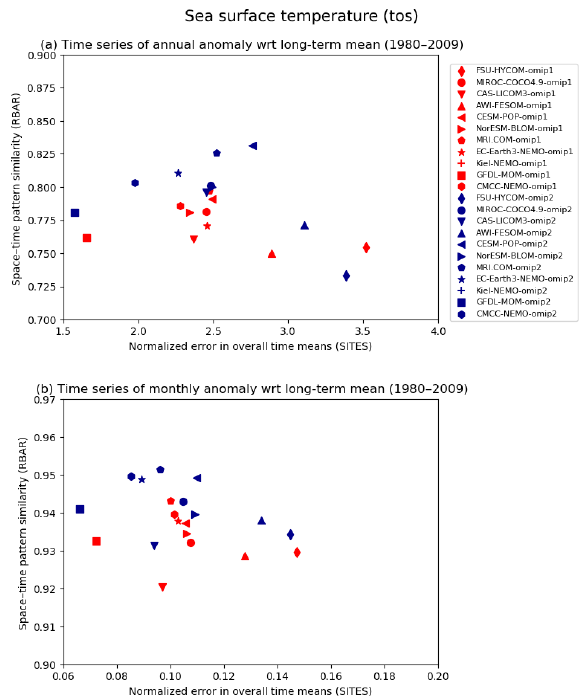
Figure E6. A model performance diagram showing the OMIP-1 and OMIP-2 simulations of (a) annual mean and (b) monthly mean SST during 1980–2009 in terms of the normalized error of the long-term annual mean (SITES; abscissa) and the temporal mean of the spatial pattern correlation coefficients (RBAR; ordinate) relative to